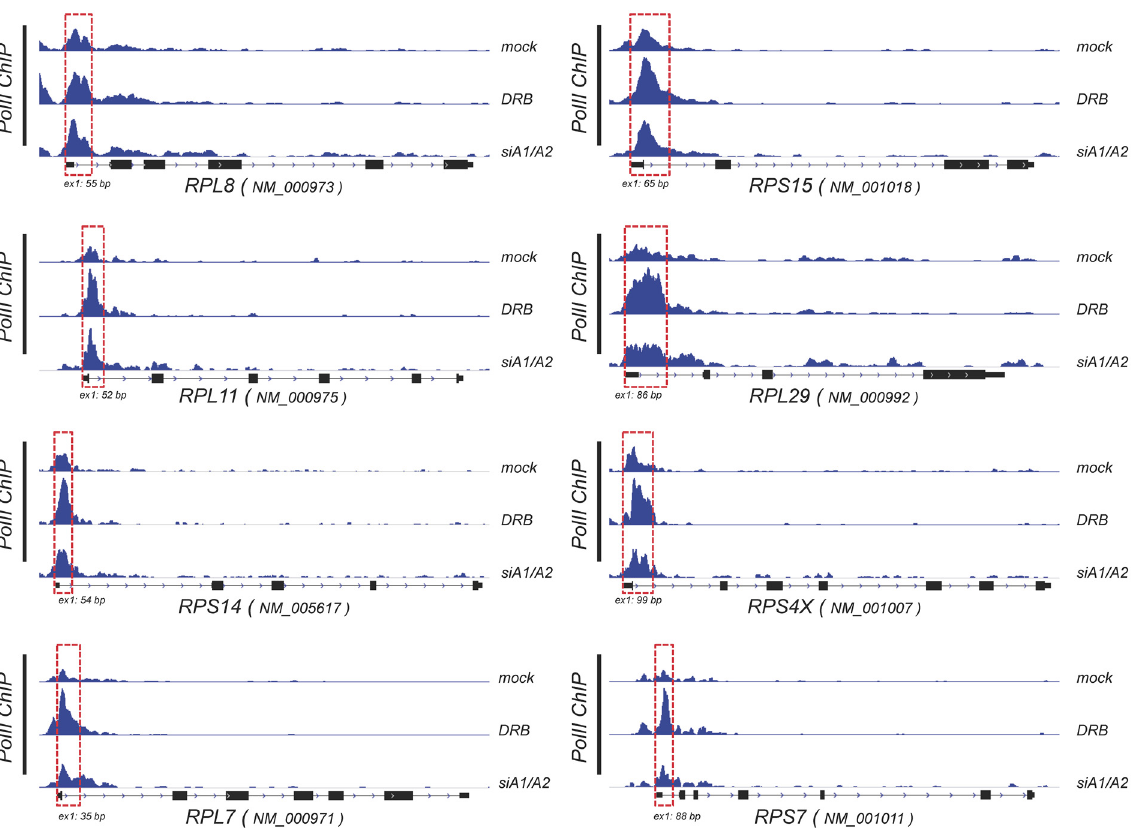
Fig 8. Changes in RNA polymerase II occupancy on ribosomal protein-encoding genes elicited by DRB and the depletion of A1/A2. Density of ChIP- seq reads for RNA polymerase II (H-224 antibody) on genes encoding ribosomal proteins (major RefSeq transcripts indicated). Genes are transcribed from left to right. The size in bp of the first exon is indicated. Red dashed boxes indicate the promoter-proximal regions displaying an increase in pol II occupancy upon treatment with DRB and the siRNA-mediated knockdown of A1/A2.